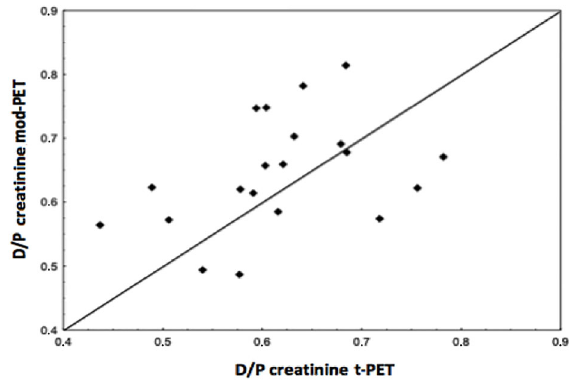
Figure 2. Correlation of dialysate-to-plasma concentration ratio (D/P) for creatinine between traditional peritoneal equilibration test (t-PET) vs modi fi ed (mod)-PET (r=0.387, P=0.009; n=20).